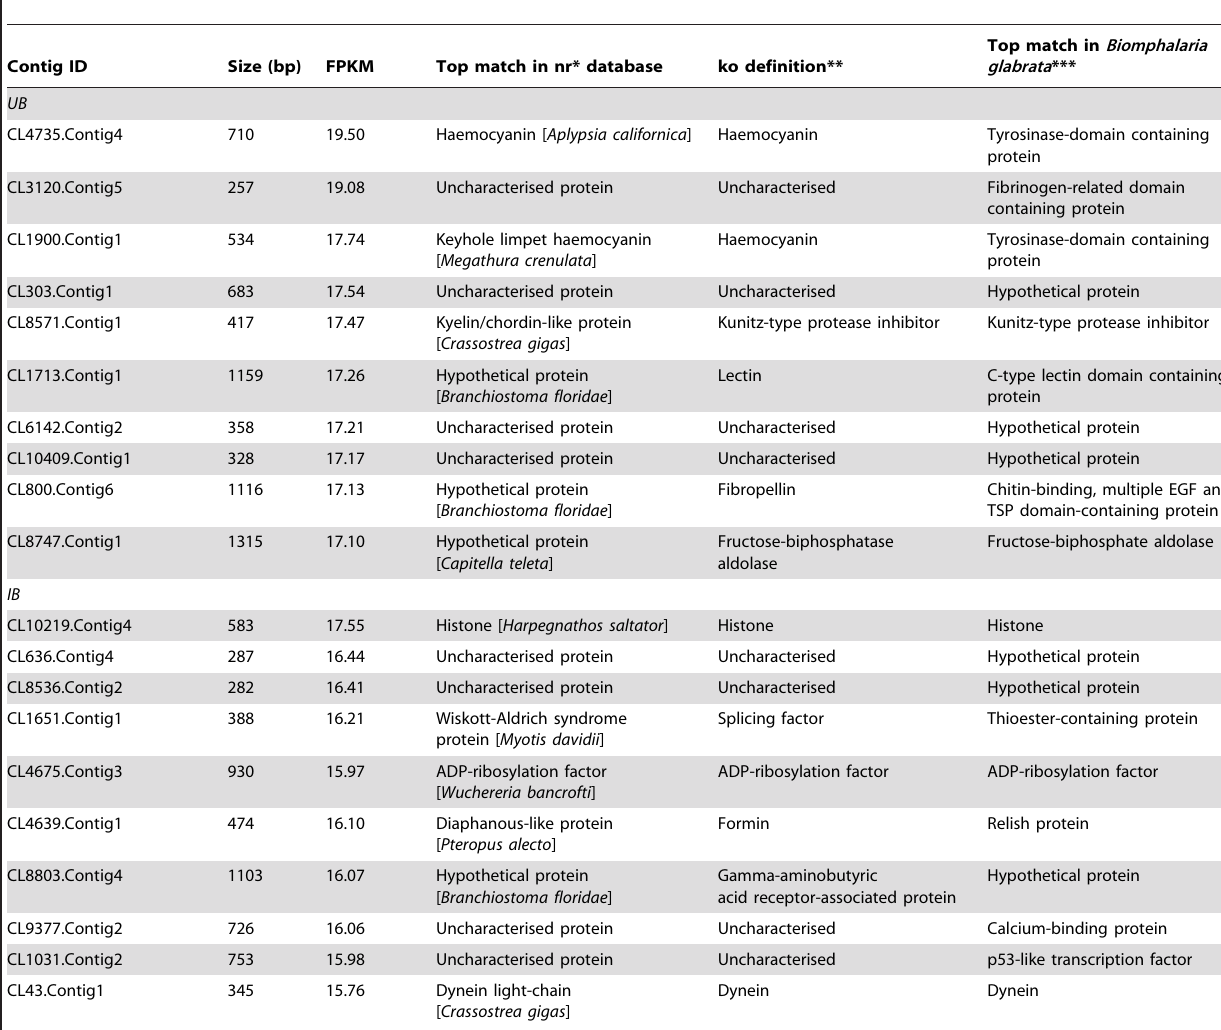
Table 2. The top-ten up-regulated genes in uninfected and Opisthorchis viverrini -infected Bithynia siamensis goniomphalos snails (UB and IB,